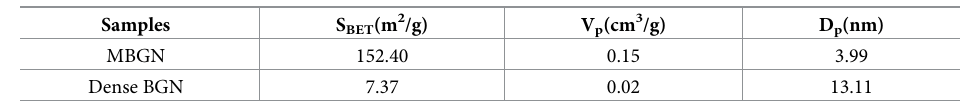
Table 1. N 2 adsorption results.